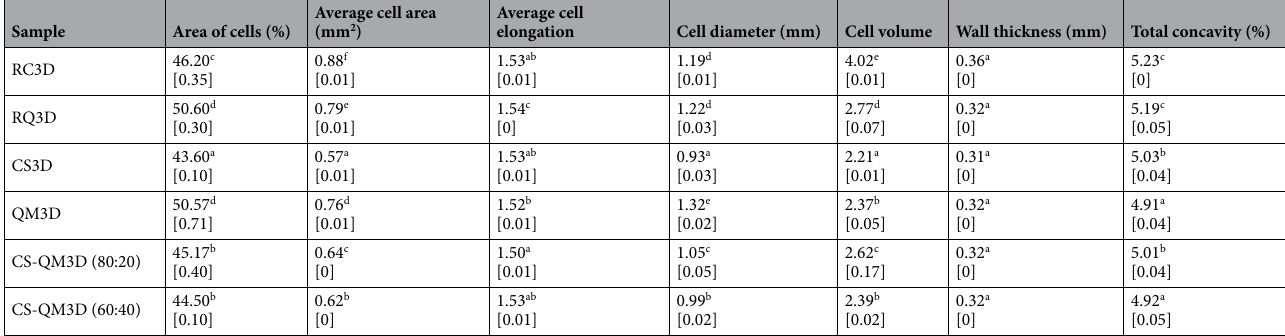
Table 5. Image analyses of the raw, cowpea sourdough, quinoa malt whole and multigrain 3D-printed biscuits. Various superscripts presented per column indicate significant differences ( p ≤ 0.05). Values in square brackets are the standard deviations of the respective means. 3D three-dimensional, RC3D raw cowpea 3D-printed biscuit, RQ3D raw quinoa 3D-printed biscuit, CS3D cowpea sourdough 3D-printed biscuit, QM3D quinoa malt 3D-printed biscuit, CS-QM3D (80:20) 80% cowpea sourdough and 20% quinoa malt 3D-printed biscuit, CS-QM3D (60:40) 60% cowpea sourdough and 40% quinoa malt 3D-printed